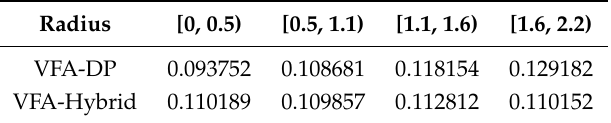
Figure 3. The global view of the final distributions from the VFA-DP and VFA-Hybrid algorithms. Table 1. The average equilibrium distance between two sensor nodes calculated from both VFA-DP and VFA-Hybrid algorithms for the specified radius where the sensor is